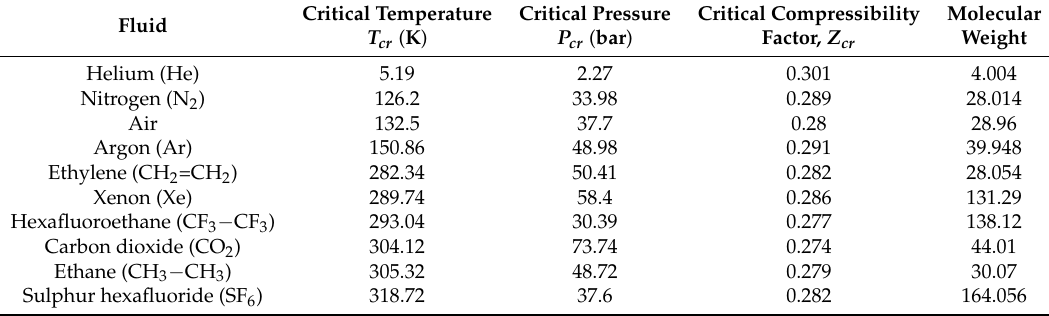
Table 1. Some properties of substances that could be used as working fluids in closed Brayton cycles. Data are from [15] (Appendix A) and